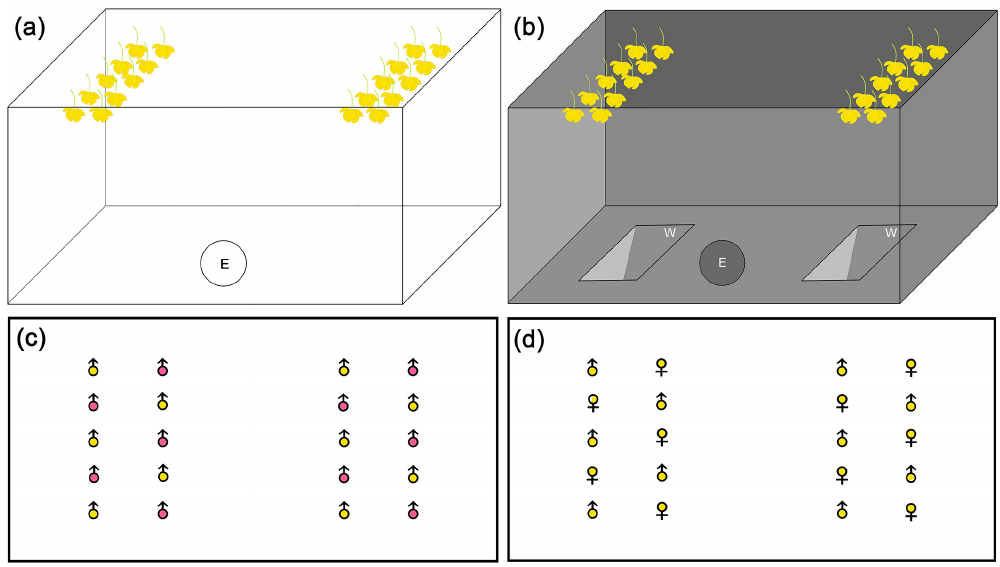
Figure 3. “Flight box” biotests. ( a ) Light-field box made of transparent polyethylene terephthalate (TPT). Fresh flowers hung on the roof plate via two lines of holes (line space = 4 cm; hole space = 2 cm; 3.5 and 5 cm from the two edges) ( b ) Dark-field boxes (TPT box placed inside a non-transparent (NT) box made of corrugated paper). E = insect entrance on the lateral side of boxes, 3 cm diameter; W = windows at the bottom plate of the NT box, which were used for insect landing observations under a lamplight. Windows were closed during testing. ( c , d ) Flower arrangement patterns on the roof plate as follows: ( c ) red and yellow male flowers; ( d ) yellow male and female flowers.